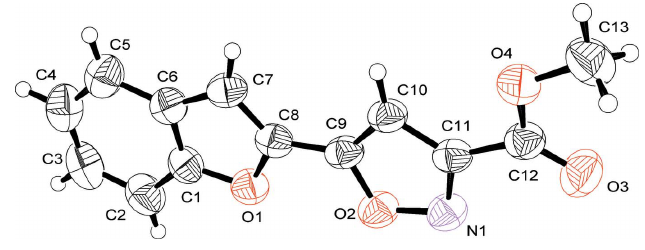
Figure 1 The molecular structure showing 50% displacement ellipsoids.